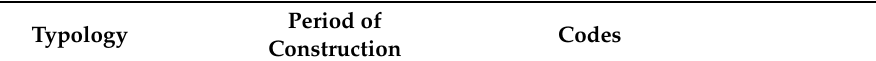
Table 1. Summary of the RC typologies found in Lisbon.